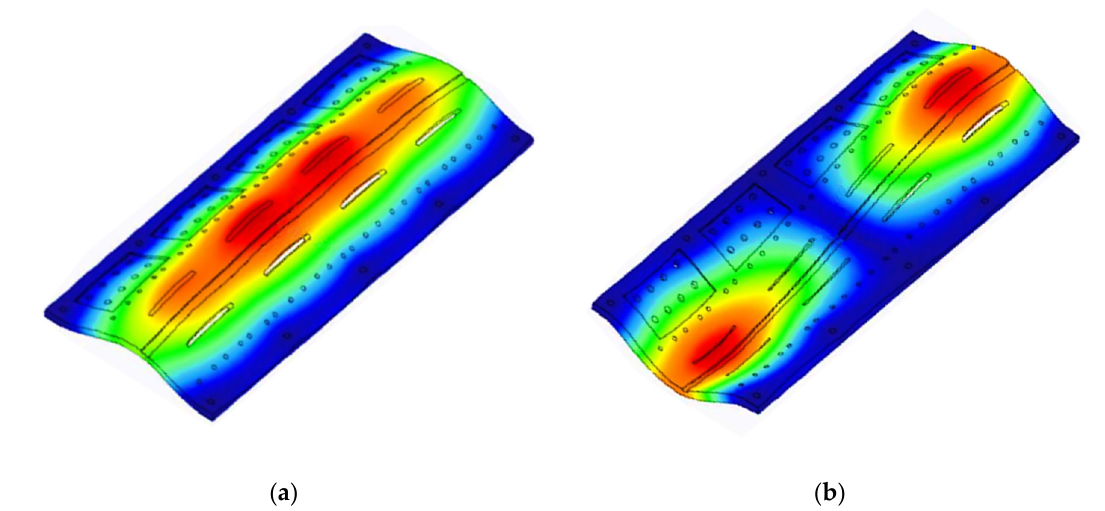
Figure 12. ( a ) First vibrational mode at 360 Hz; ( b ) second vibrational mode at 386 Hz.